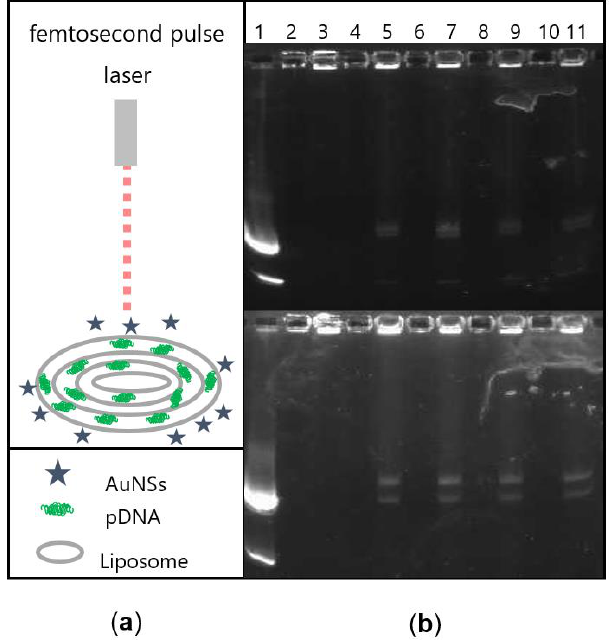
Figure 3. ( a ) Scheme of irradiation and ( b ) Agarose gel electrophoresis of lipoplex-AuNS systems under non-irradiated (lanes 2, 4, 6, 8 and 10) and irradiated (lanes 3, 5, 7, 9 and 11) conditions, at 400 mW (top panel) and 700 mW (bottom panel) for 5 min. The lipoplex-AuNS systems were prepared at different AuNS concentrations: 20 pM (lanes 2–3), 50 pM (lanes 4–5), 100 pM (lanes 6–7), 150 pM (lanes 8–9) and 200 pM (lanes 10–11). Free pDNA was used as the control (lane 1).